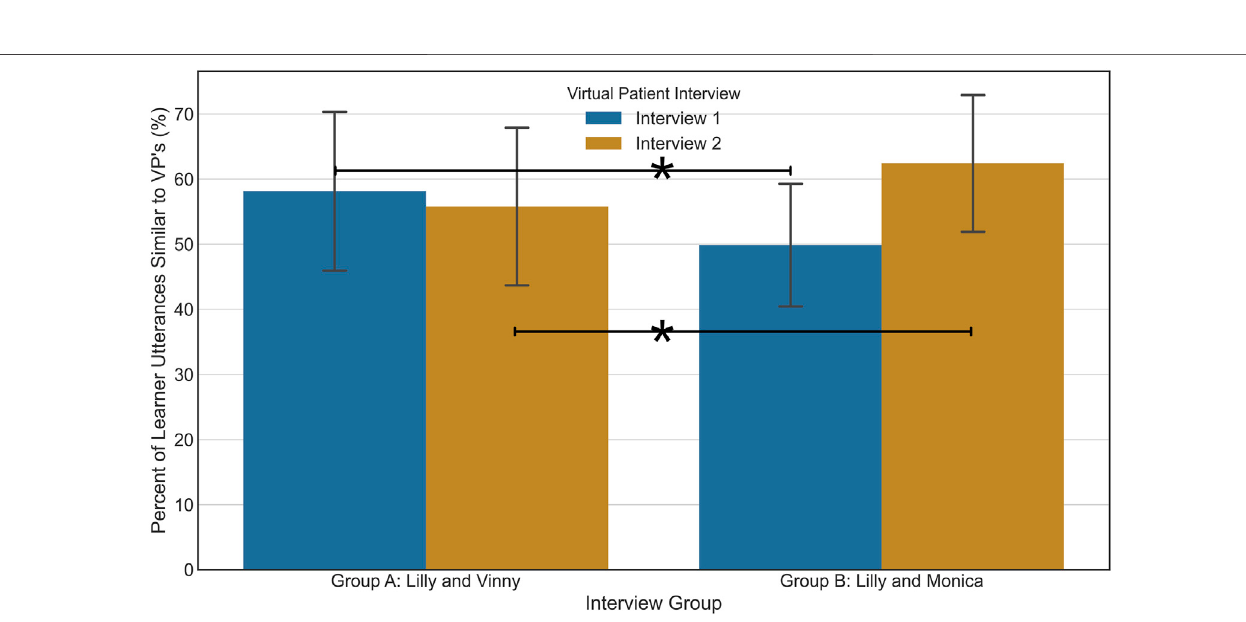
Frontiers in Virtual Reality |